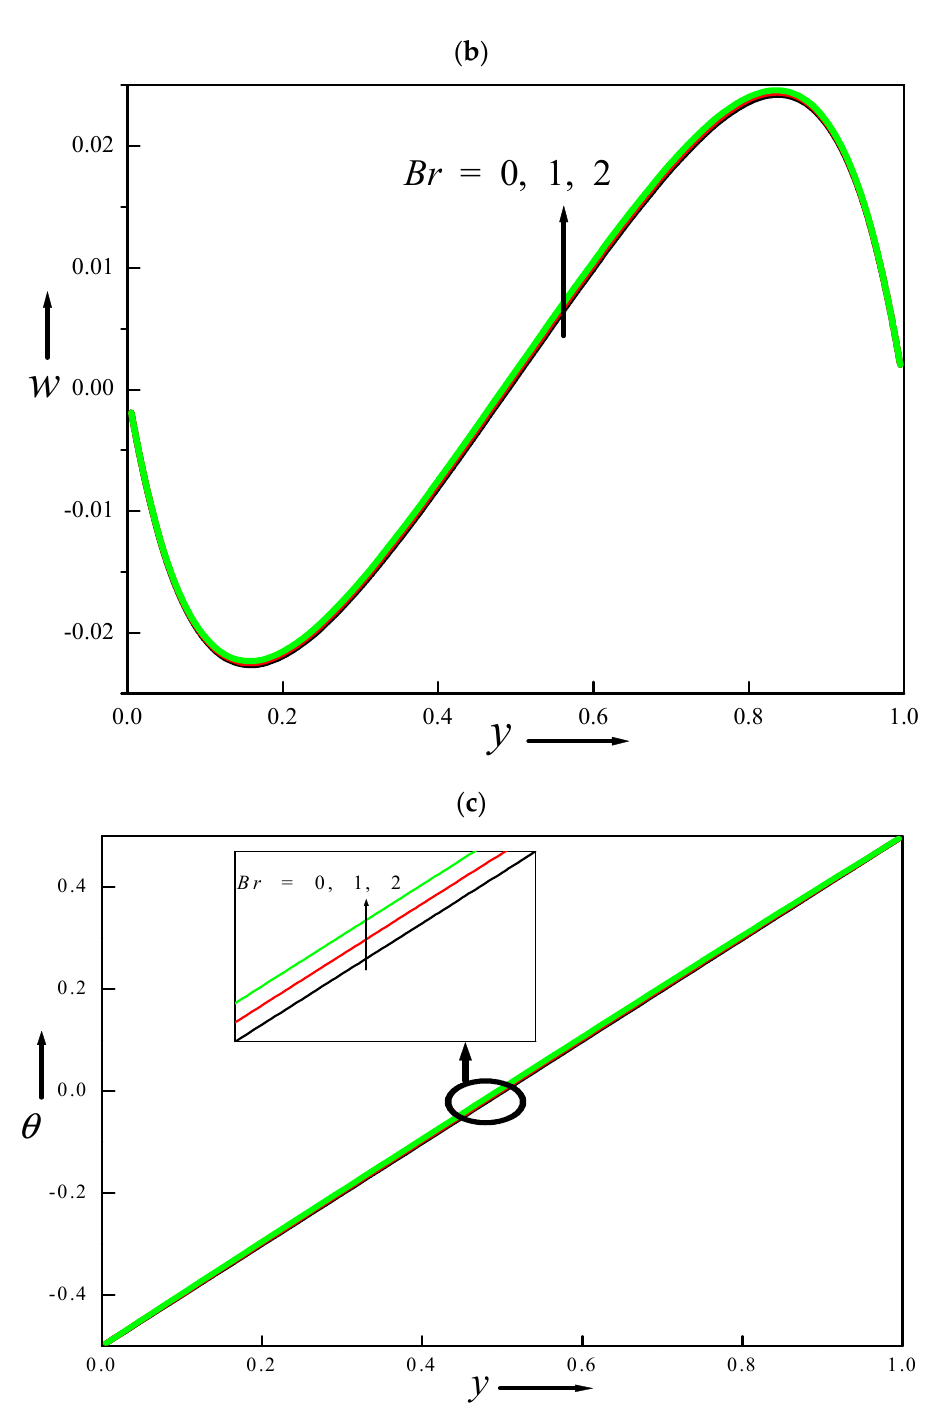
Figure 11. Velocity ( a ) contours, ( b ) profiles, and ( c ) temperature profiles for altered Brinkman number.